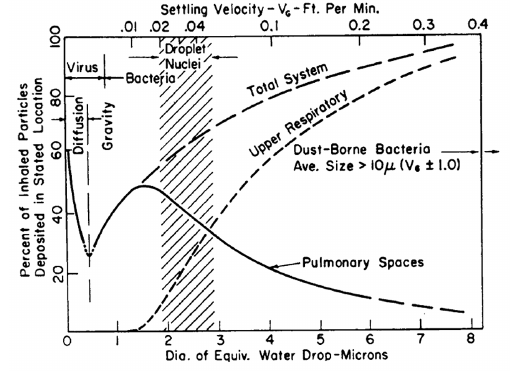
Figure 3: Total and regional deposition of inhaled particles, in rela- tion to the aerodynamic particle size. Reproduced from Hatch [9] with permission from the American Society of Microbiology. 1 mi- cron = 1 μm [micrometer] = 0.001